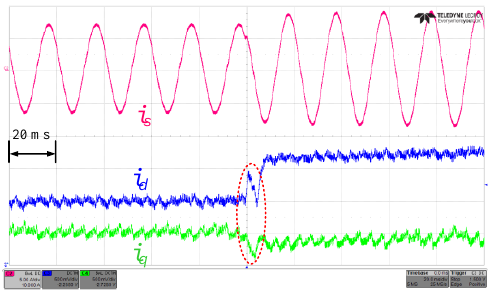
Figure 11. Experimental results with the proposed control strategy while the virtual closed-loop circuit is removed.